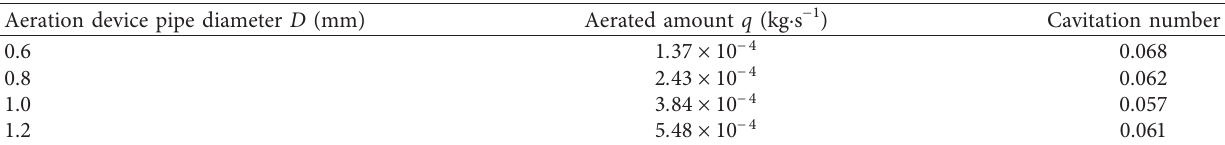
Table 2: Aeration quality and cavitation